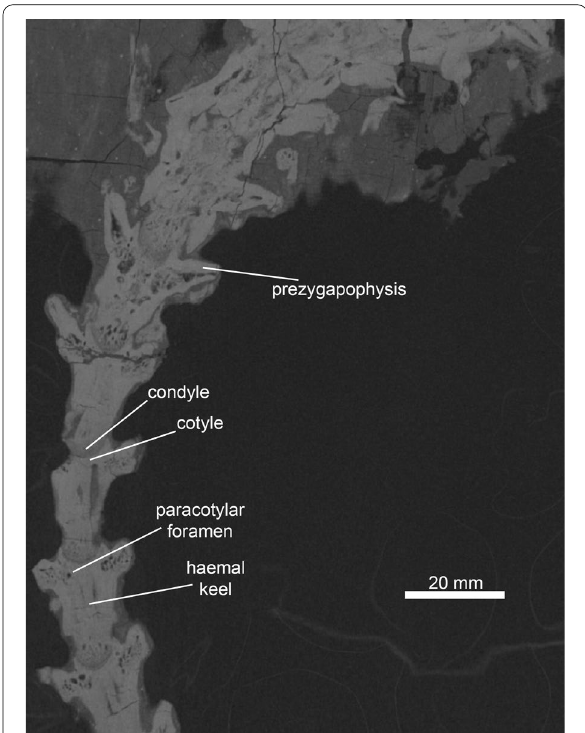
Fig. 4 Colubriformes indet. (PIMUZ A/III 191) from the middle Miocene of Käpfnach, Switzerland. Axial section of the micro-CT scan, indicating the presence of paracotylar foramen (note that this is only one section, more or less horizontal, through the vertebra, and as such, does not show the location of the foramen as would be visible from outside, but only a single position of the foramen as it enters and progresses into and extends within the